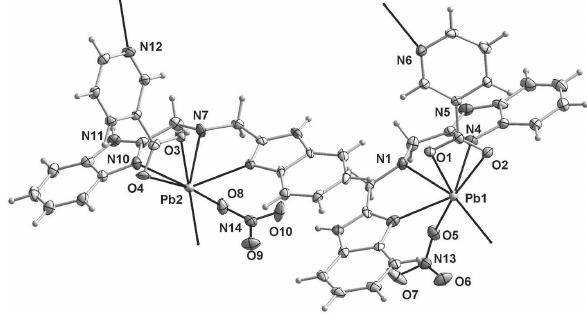
Table 1: Data collection and